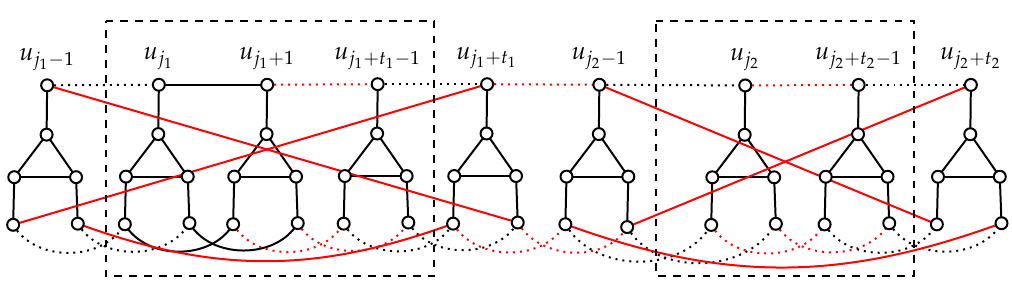
Figure 6. Illustrating Algorithm C for constructing P (cid:48)(cid:48) from P ( 3 k , k )